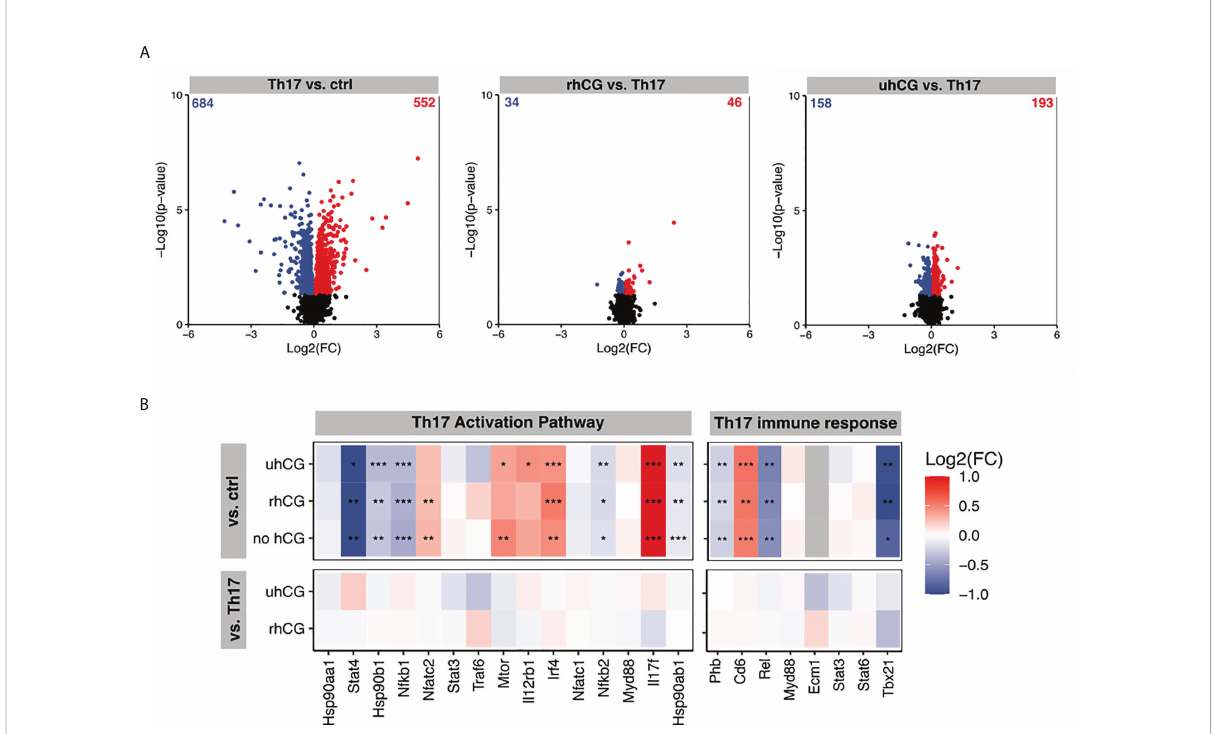
FIGURE 3 rhCG and uhCG did not alter molecules of the Th17 activation pathway and Th17 immune response. Naïve CD4 + T cells were polarized into Th17 cells for 3 days in the presence of 250 IU/ml uhCG or 500 mIU/ml rhCG. Differentiated cells cultured in the absence of hCG or non- polarized cells served as controls. Afterwards, proteome analyses were performed. (A, B) Overview of regulated proteins in Th17-polarized cells. (A) Summary of obtained Log2(FCs) and – Log10 (p-values) after naïve T cells were polarized into Th17 cells in the presence or absence of rhCG or uhCG. Signi fi cantly altered proteins were highlighted either blue (p 0.05, Log2 FC < 0) or red (p 0.05, Log2 FC > 0) ( n = 4). (B) Ingenuity pathway analyses (IPA) of molecules involved in the Th17 activation pathway and immune response. * indicates p < 0.05; ** indicates p < 0.01; *** indicates p < 0.001. rhCG, recombinant hCG; uhCG, urine-derived